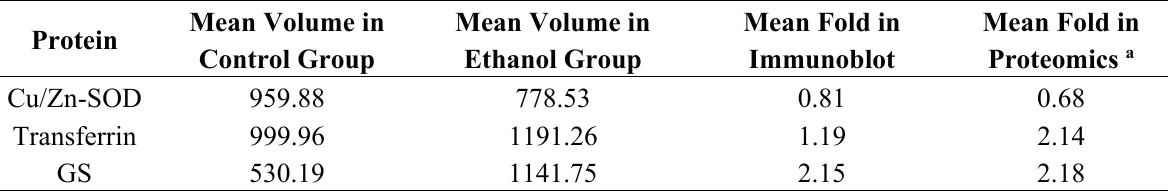
Table 5. Comparison of protein expression in the immunoblot between control and ethanol-fed groups. The volumes in immunoblot were calculated by ImageMaster II software ( n = 3).